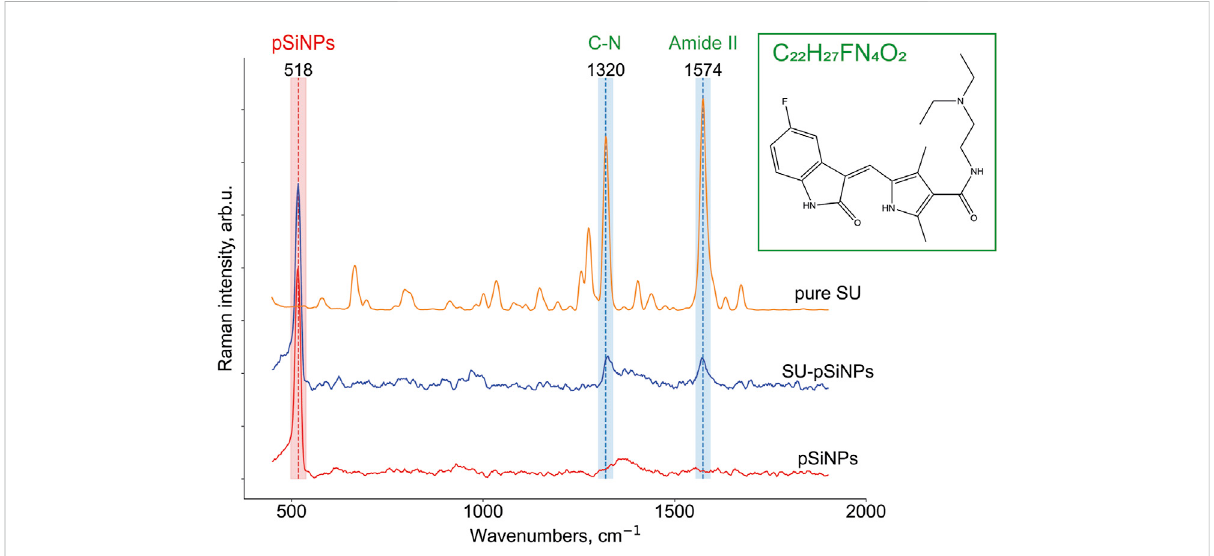
FIGURE 3 RamanreferencespectraofcrystallizedSU(C 22 H 27 FN 4 O 2 ; N -[2-(diethylamino)ethyl]-5-[( Z )-(5- fl uor-1,2-dihydro-2-oxo-3H-indol-3-ylidene)- methyl]-2,4-dimethyl-1H-pyrrole-3-carboxamide),depictedinorange,ofsolutionsofSUloadedinpSiNPs(SU-pSiNPs,depictedinblue)andofpure Si nanocontainers (pSiNPs, depicted in red) dissolved in deionized water for 24 h. The Raman spectra were preprocessed (see Section 2 for the details) and the characteristic Raman bands at 518 cm − 1 for pSiNPs, and 1320 cm − 1 and 1574 cm − 1 for SU, respectively, were speci fi